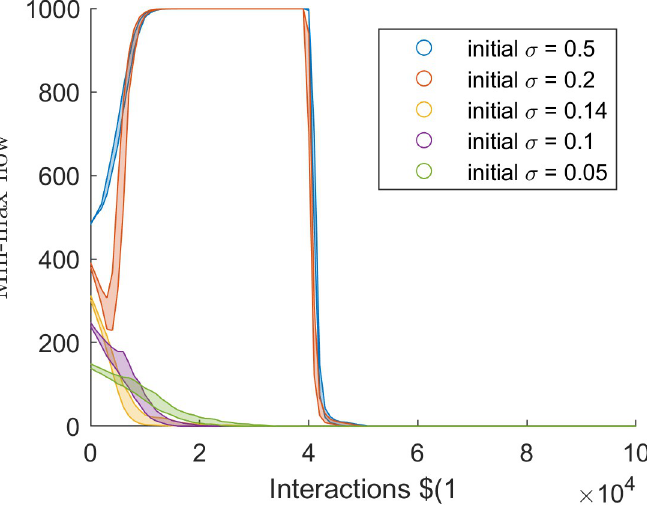
Fig 5. Min-max flow, k , through time of the simulations that used the Martins model with different values of initial uncertainty.